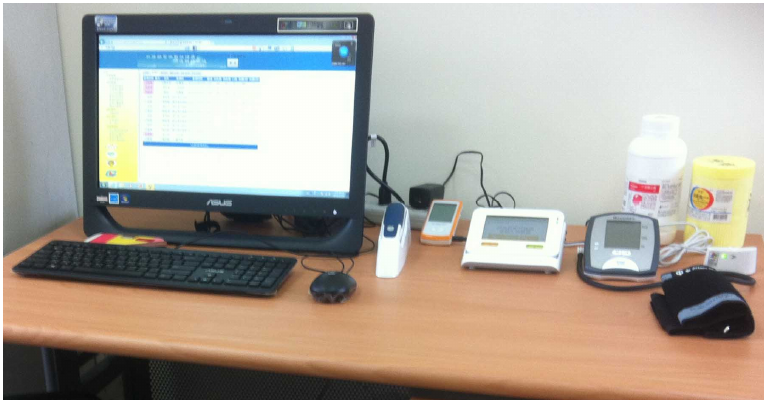
Figure 2. The telehealth